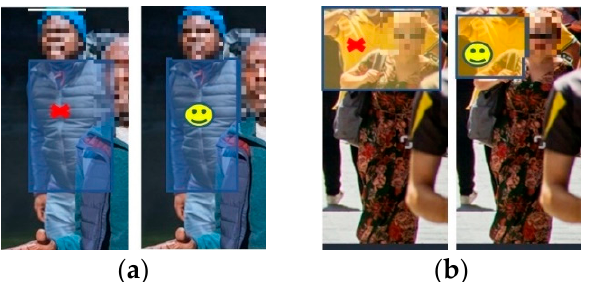
Figure A5. ( a ) shorts should be annotated as trouser, ( b ) class shirt means any clothes in the upper body part. 6. We added this rule later in the work: Make sure that no shirt or trouser includes any part from the person’s face as this will cause confusion to the model, and it will label any Bbox with a face as a shirt.